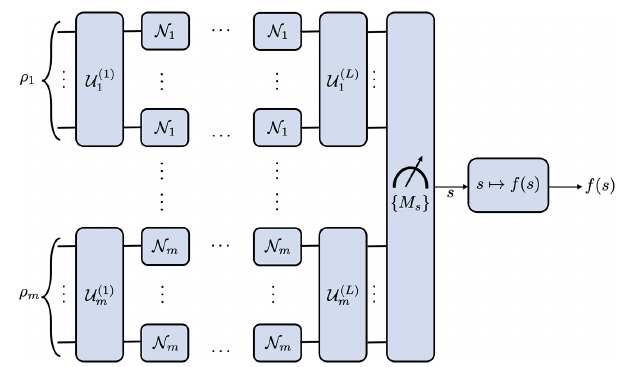
FIG. 1. Schematic of an error-mitigation